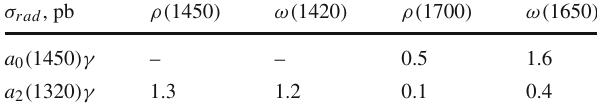
Table 6 The predicted contributions to the e + e − → ηπ 0 γ cross sec- tion from the radiative decays of the exited vector mesons in pb. The predictions are based on the partial widths calculated in Ref. [10] σ ρ( 1450 ) ω( 1420 ) ρ( 1700 ) ω( 1650 ) rad , pb a 0 ( 1450